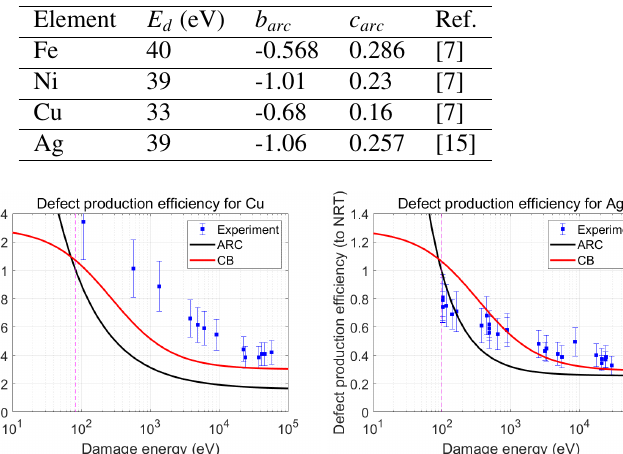
Figure 2. Ratios of Averback’s experimental data [6], ARC- DPA, and CB-DPA to the NRT formula for Cu and Ag versus damage energy computed with the DPA weighted average PKA energy. The corresponding uncertainties are form the uncertain- ties of sample thickness and electronic